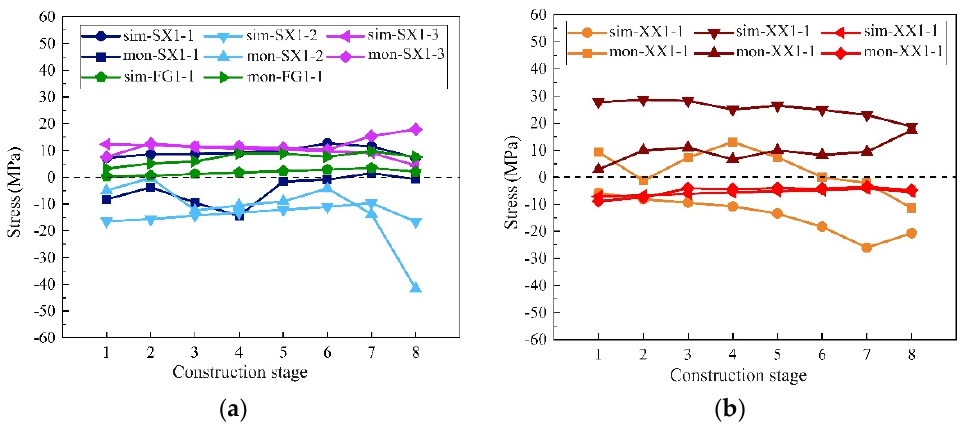
Figure 21. Comparison of stress results. ( a ) Measuring points on the upper chord and belly bar, ( b ) Measuring points on the lower chord.